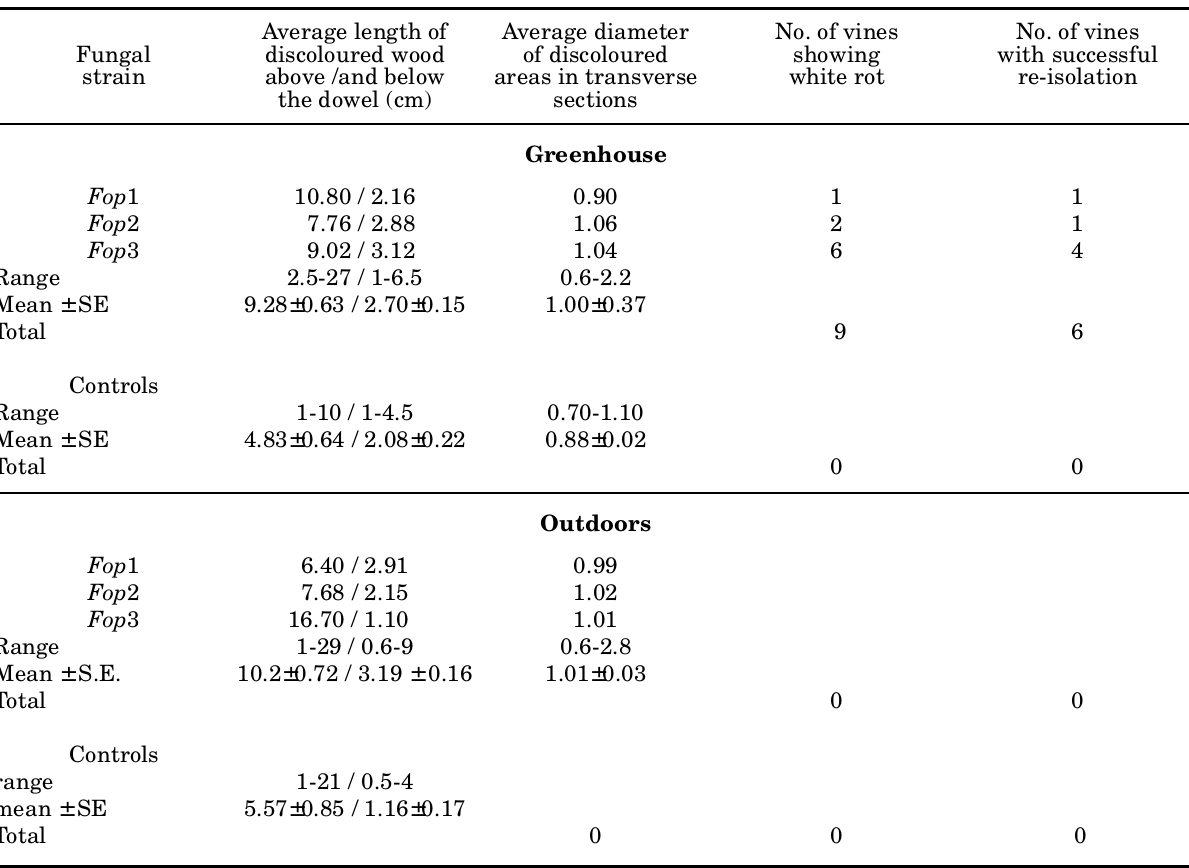
Table 3. Results of a 21-month experiment with three strains of F. punctata inoculated on the stem of 2-year-old grafted grapevines cv. Italia/Kober 5BB a